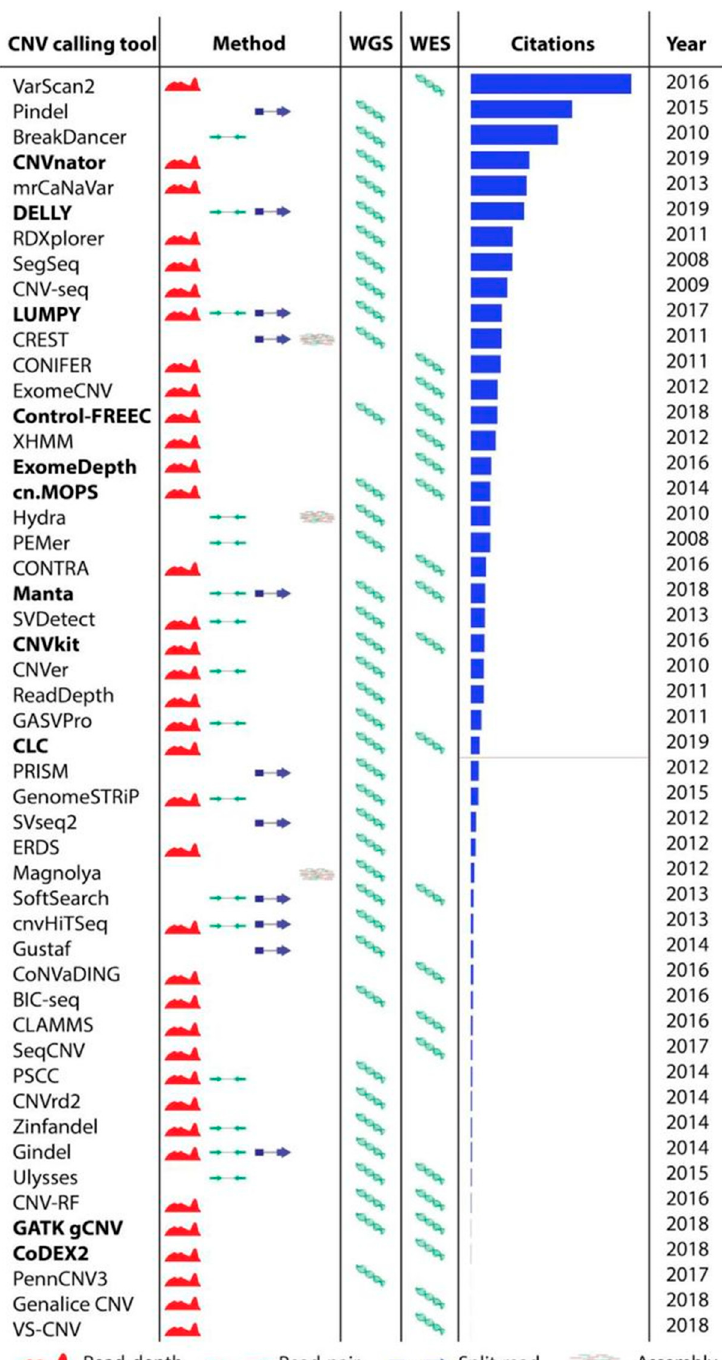
Figure 2. Overview of methods CNV calling tools applies, input NGS data, citation number from Google Scholar and available latest version for each tool as of March 2019. Tools highlighted with bold font are included in the benchmark, the horizontal red line shows the cutoff for the citation number.